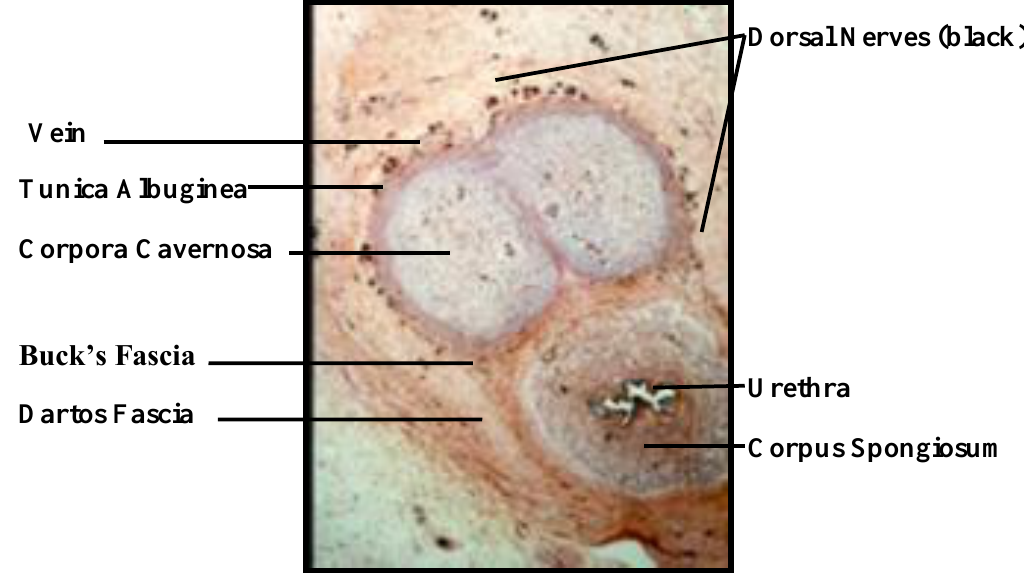
FIGURE 2. Histology of penile anatomy in cross-section. Note that the dorsal nerves start at the 11 and 1 o’clock positions of the corpora cavernosa and extend around laterally to the cavernosal-spongiosal junction. There is a notable paucity of nerves at the 12 o’clock